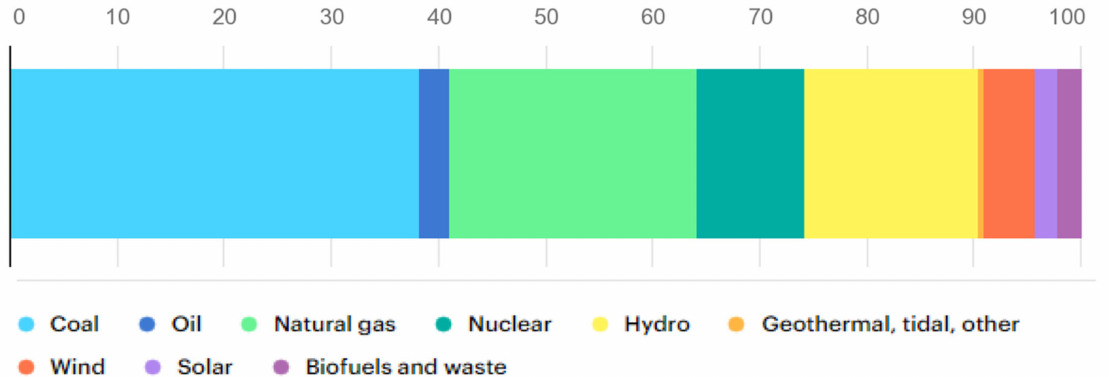
Figure 4. World gross electricity production, by source, 2018 (Source: IEA (2020), World gross electricity production, by source, 2018, IEA, Paris https://www.iea.org/reports/electricity-information-overview as modified by the authors. All rights reserved) (adapted from